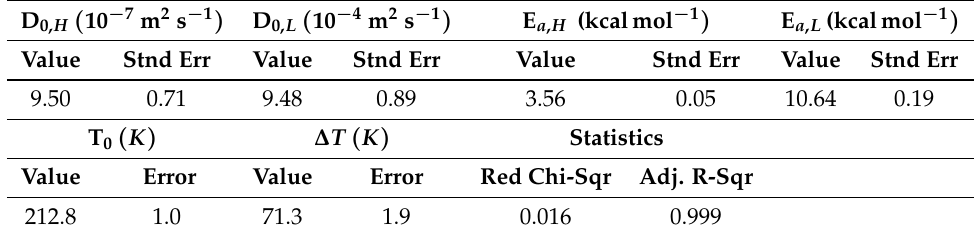
Table 1. Fitting results of the two-states model applied to the water self-diffusion data, reported in Figure